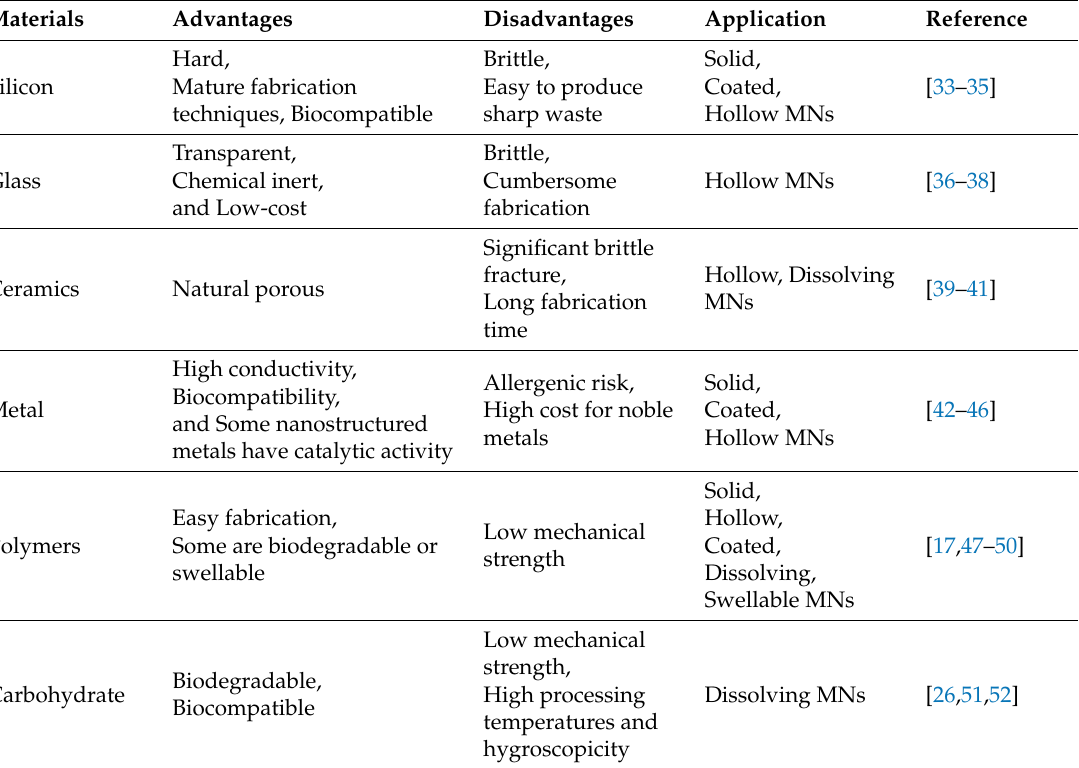
Table 1. Materials for fabrication of microneedles